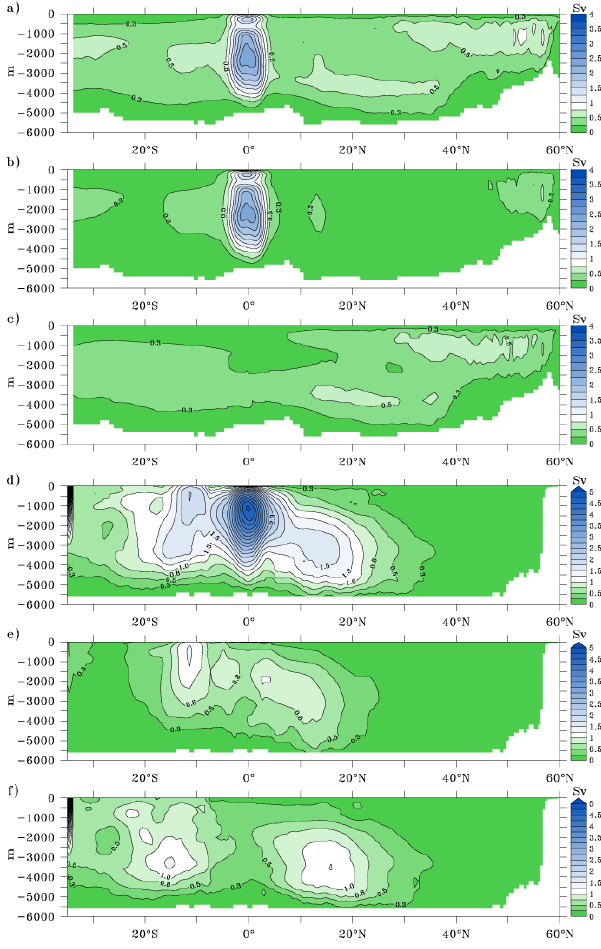
Figure 12: Chaotic Atlantic (a,b,c) and Indo-Pacific (d,e,f) MOC variability for the eddy permitting Fig. 12. Chaotic Atlantic (a) , (b) , (c) and Indo-Pacific (d) , (e) , experiments (A025, B025). a) Unfiltered chaotic MOC variability (based on 5-day averages). b) Subannual (f) MOC variability for the eddy-permitting experiments (A025, chaotic MOC variability. c) Chaotic MOC variability on interannual timescales. d,e,f) as a,b,c but for B025). (a) Unfiltered chaotic MOC variability (based on 5-day av- Indo-Pacific. Units are Sv and the contour interval is 0.25 Sv. erages). (b) Subannual chaotic MOC variability. (c) Chaotic MOC variability on interannual timescales. (d) , (e) , (f) as (a) , (b) , (c) but for Indo-Pacific. Units areSv and the contour interval is 0.25Sv.